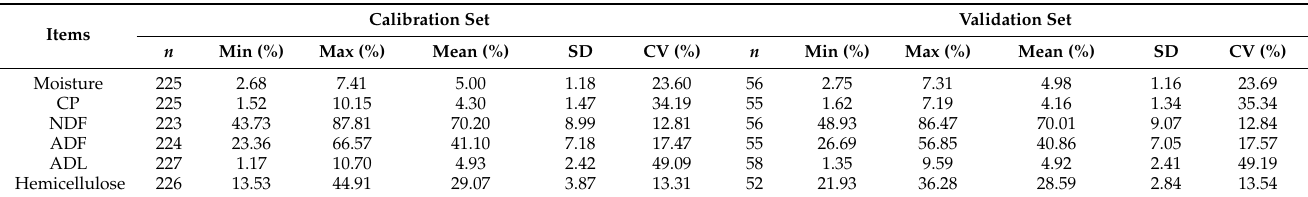
Table 5. Descriptive statistics for the six constituents of straw used for the development of NIRS calibration and validation models.